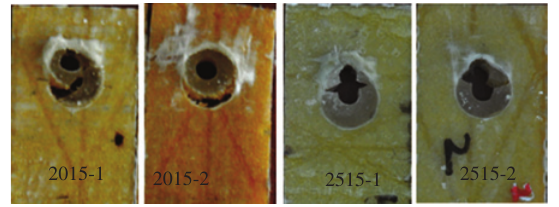
Figure 12 Images of the damaged samples of configurations E = 20 and 25 mm and D = 15 mm.